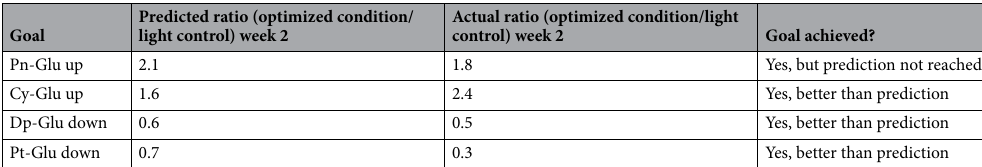
week 2 compared to the light control, which is even better than predicted. With one DoE experiment and one control experiment it is not yet proven that those optimized conditions are the perfect conditions for Pn-Glu